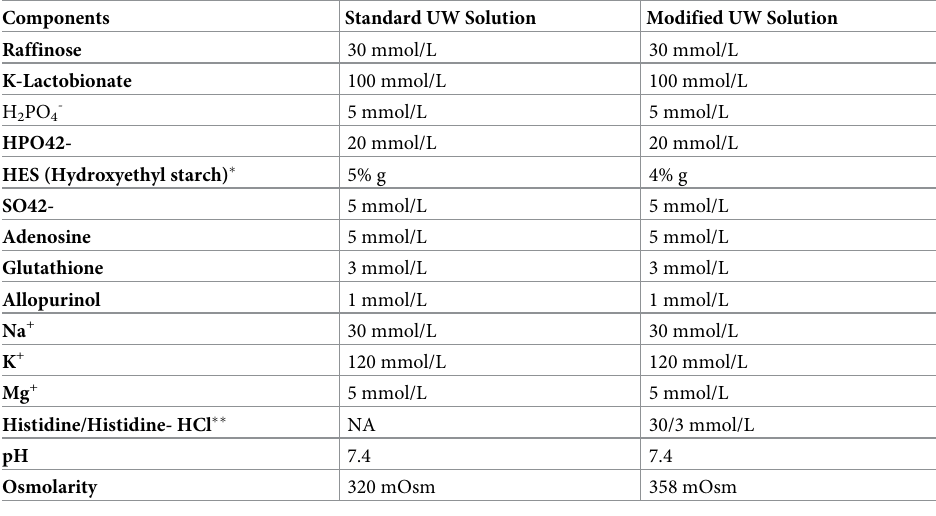
Table 2. The composition of modified UW solution used in experimental